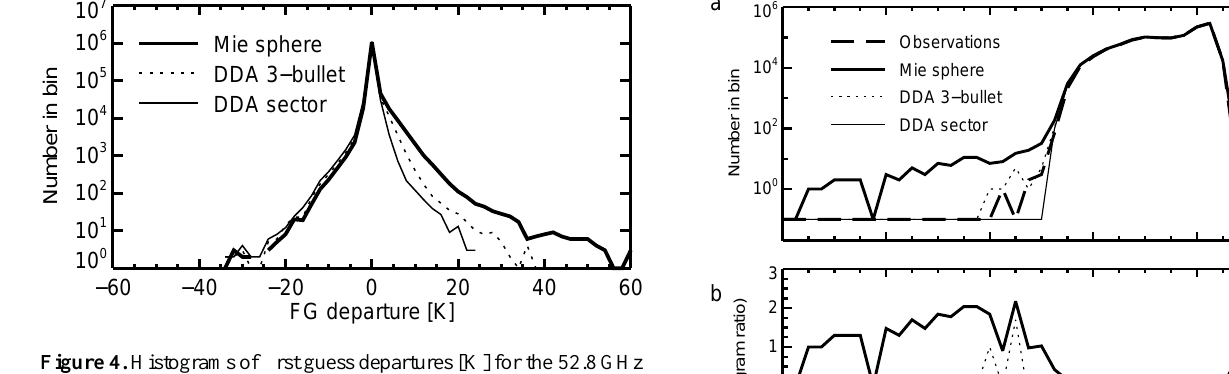
Figure 4. Histograms of first guess departures [K] for the 52.8GHz channel on SSMIS using different scattering models. Bin size is 2.0K. The sample is composed of all superobs in June 2012 passing the basic quality control tests described in Sect. 2.2.